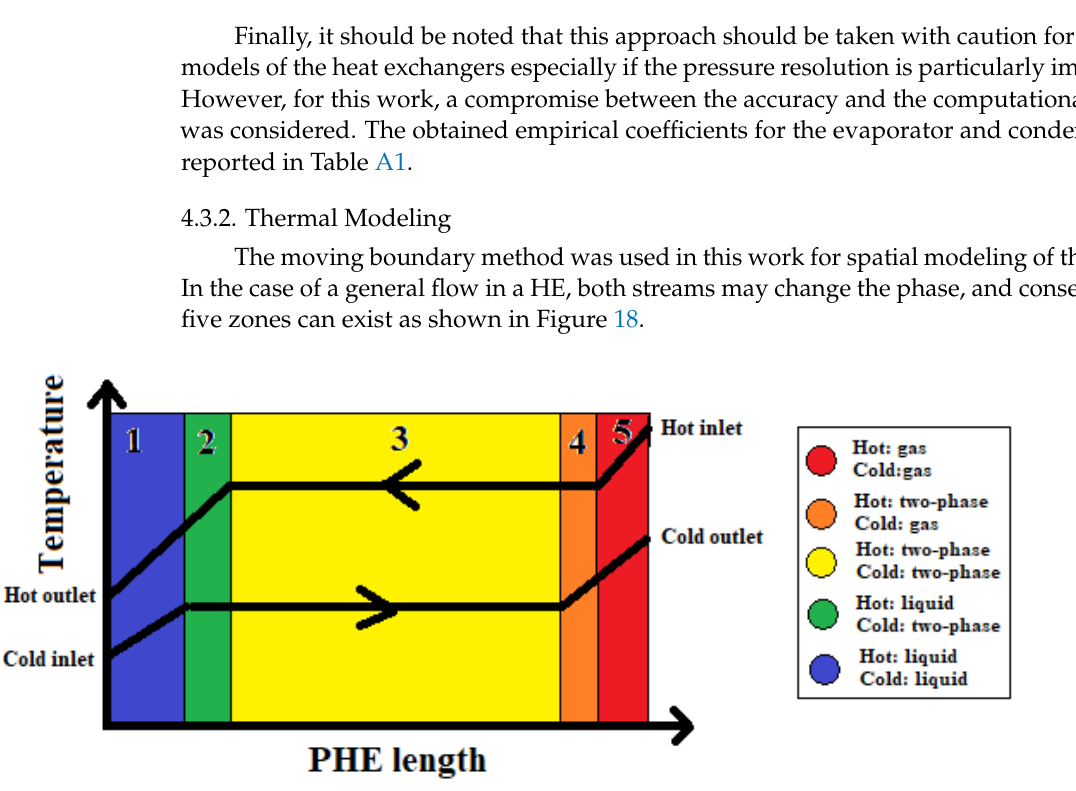
Figure 17. The calculated and measured pressure drop of the evaporator ( left ) and pressure resolution in different heat transfer zones in the evaporator ( right ).